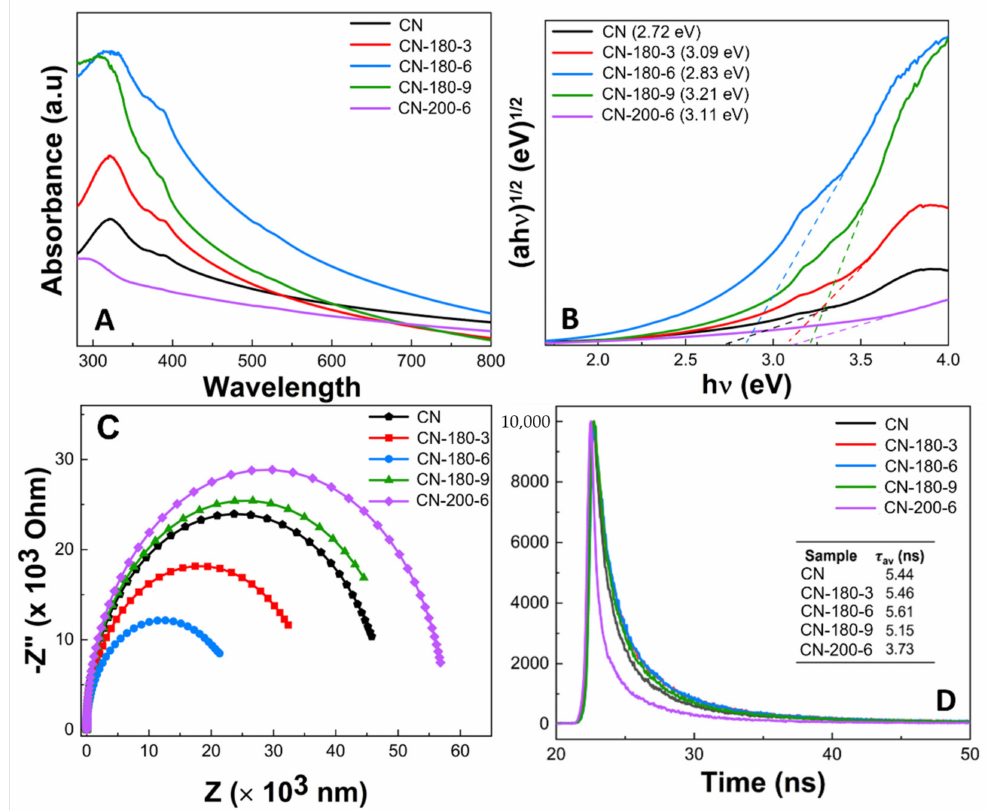
Figure 5. ( A ) UV–Vis DRS absorption spectra, ( B ) Tauc plots for the band gap, ( C ) the EIS Nyquist plots, and ( D ) time-resolved fluorescence decay spectra in the ns time scale with excitation 400 nm (inset table: the calculated average fluorescence lifetime ( τ av )) of as-synthesized CN-180-x and CN-200-6